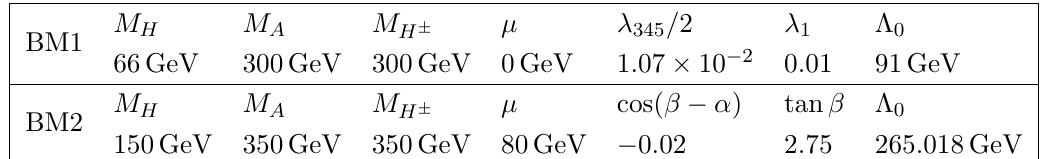
Table 1. Input parameters for our benchmark points. In BM1, the combination (cid:21) 345 (cid:17) (cid:21) 3 + (cid:21) 4 + (cid:21) 5 corresponds to a dark matter portal coupling in the IDM [39], and (cid:22) = Z 2 -breaking parameter. Masses are assumed to be the physical pole masses, while the remaining parameters are input directly in the MS scheme at the initial renormalization scale (cid:3) 0 .